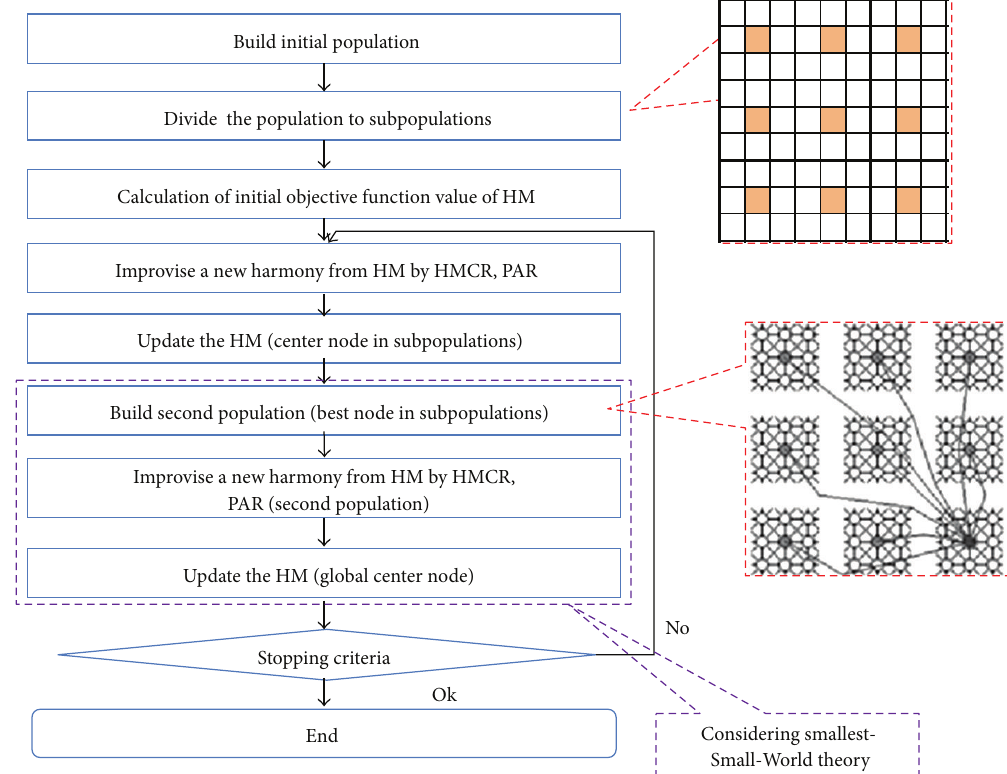
Figure 6: Flowchart of the